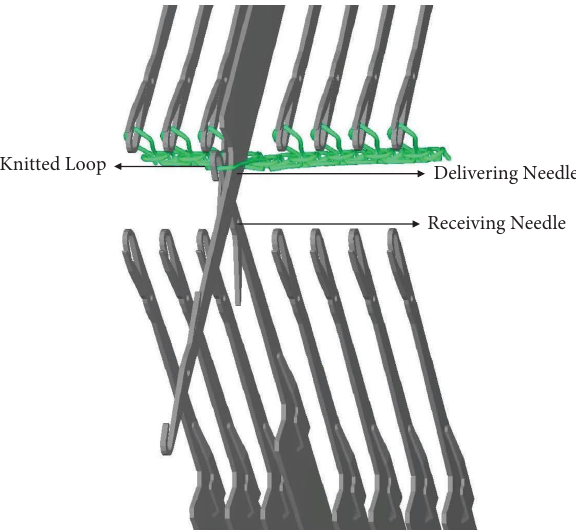
Figure 6: Animated view of receiving needlework during stitch transfer process using the apex III design system.